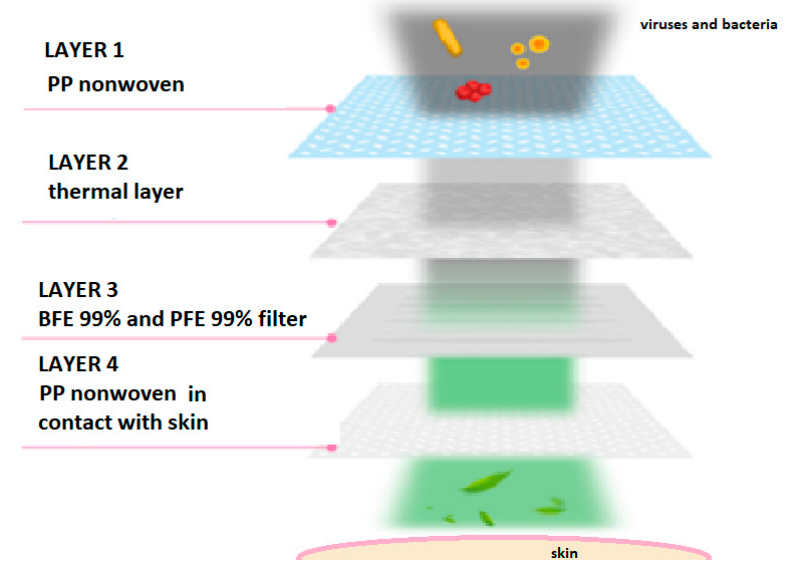
Figure 1. Surgical face masks layers.